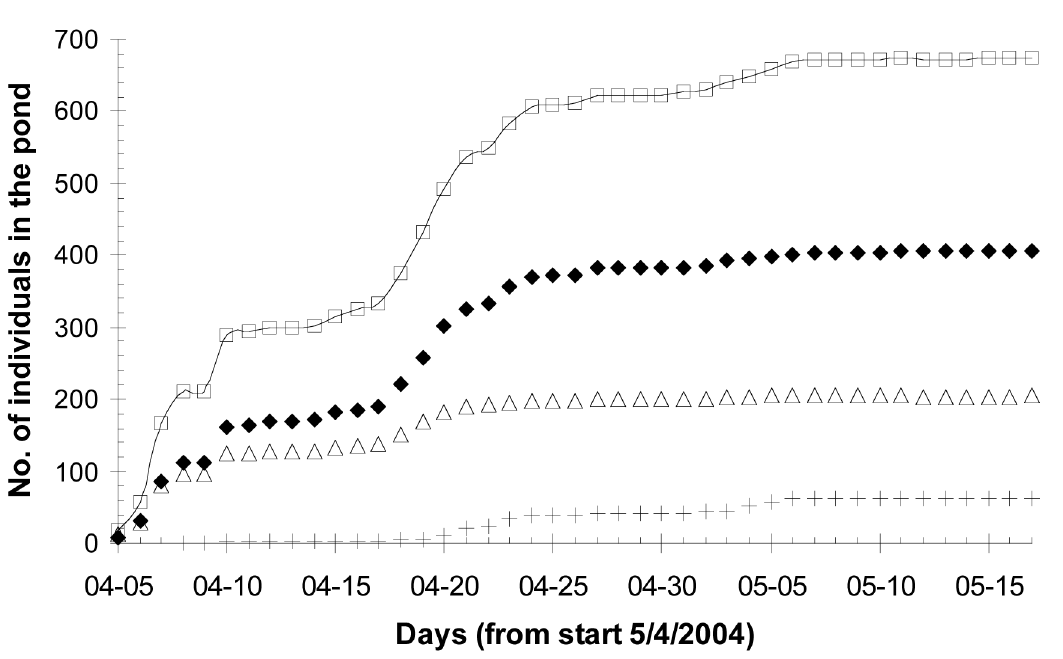
Fig. 3. Number of great crested newts ( (cid:1) = total; ◆ = females; ∆ = males; + = juveniles) in pond 7 during the study period. The pond was monitored by means of a drift fence with pitfall traps during April 4 to May 17 in 2004. Trapped animals were registered and released on the other side of the fence